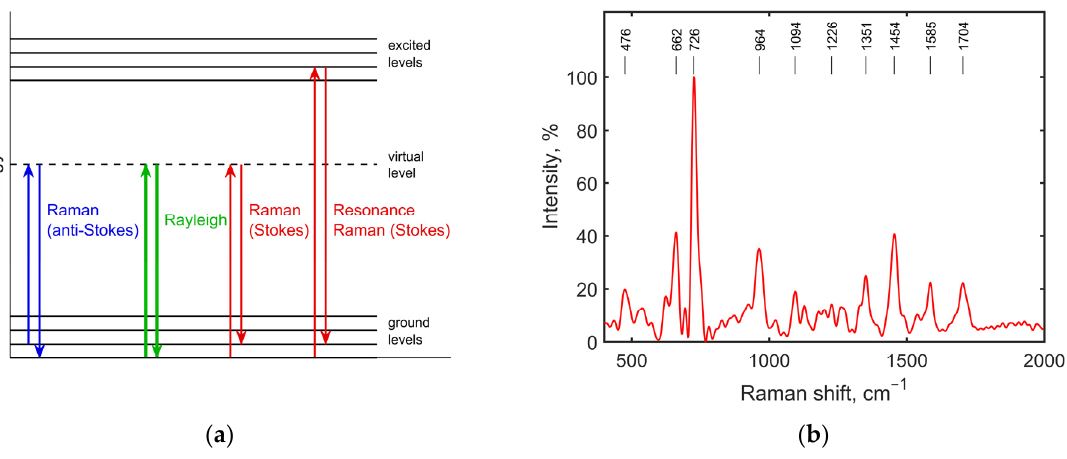
Figure 4. Mechanism of Raman scattering ( a ) and an example of E. coli SERS spectrum ( b ) with 785-nm excitation (replotted using data from [29]).